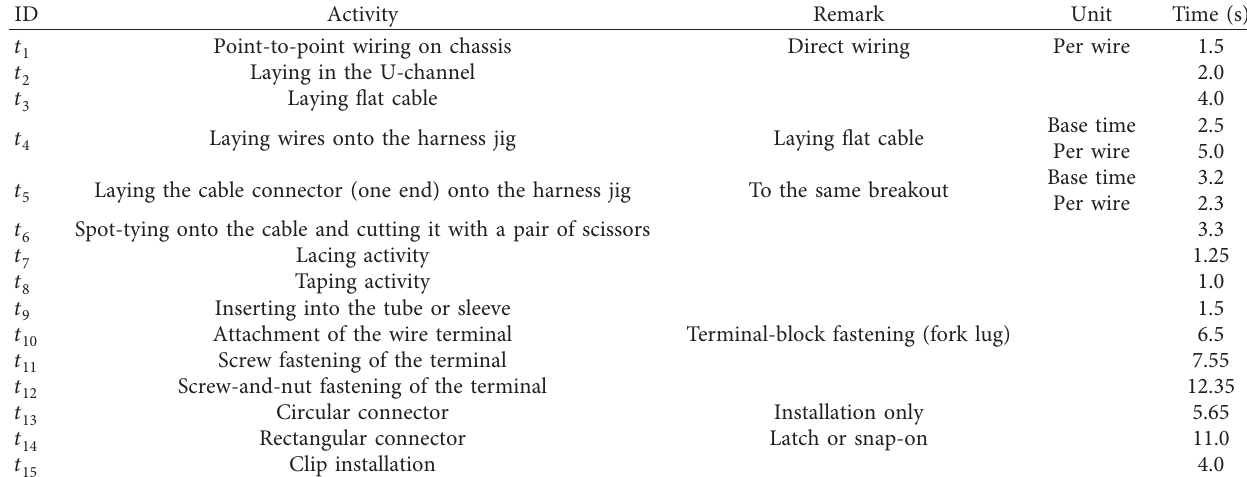
Table 5: Details of the activities during the wire harness